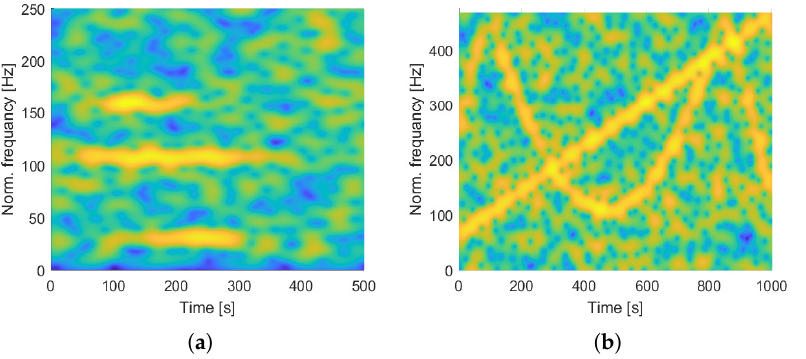
Figure 9. Entropy maps obtained by applying the 2DLEM method with the Rényi measure for SNR = 0 dB. ( a ) Entropy map for the first signal. ( b ) Entropy map for the second